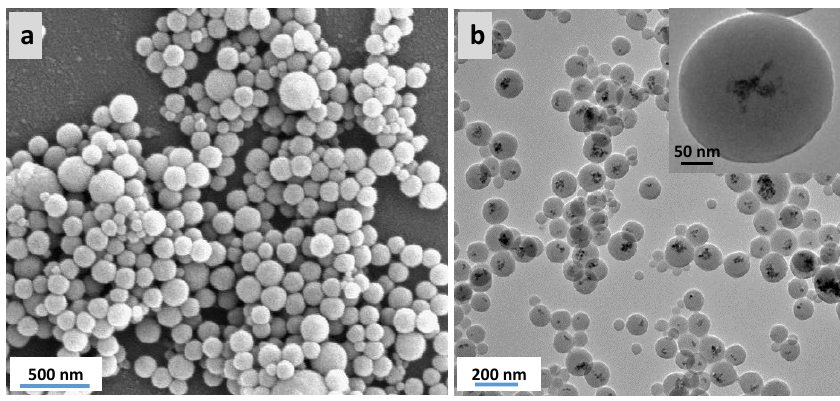
Figure 2. ( a ) SEM and ( b ) TEM micrographs of M-Phenylene PMO nanoparticles (NPs).